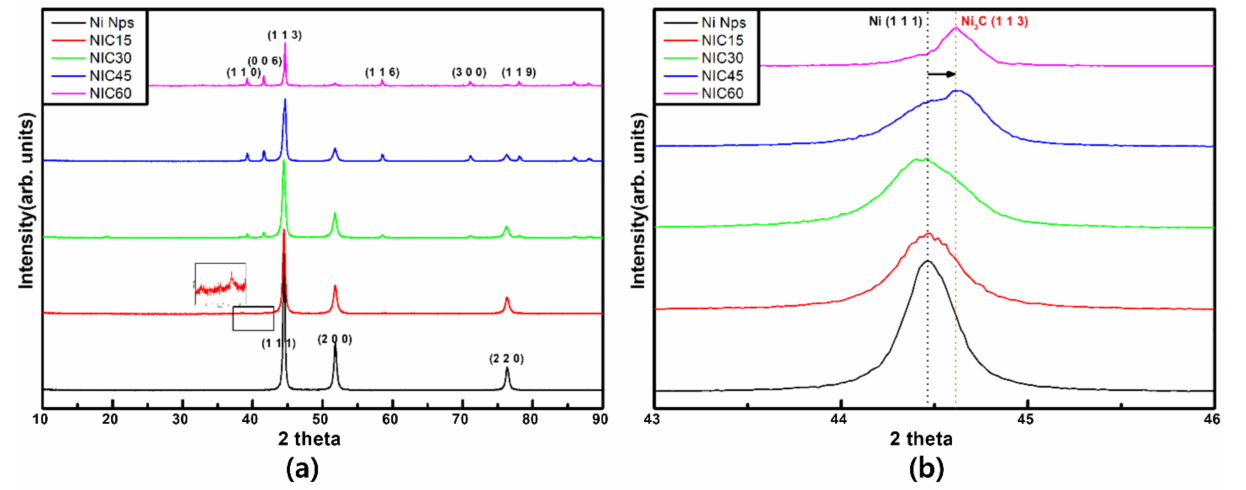
Figure 3. ( a ) XRD data of Ni Nps and NICs. ( b ) Enlarged graph showing the major peaks of Ni and Ni 3